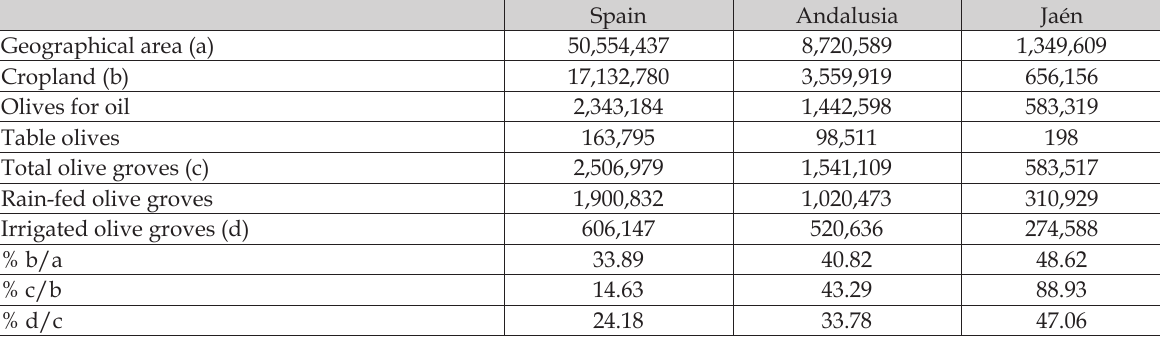
Table 1. Importance of olive cultivation at the national, regional and provincial (Jaén) scales in 2014 (area in hectares).